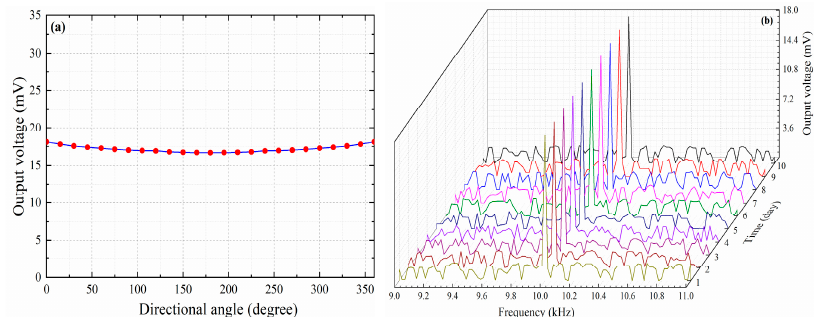
Figure 12. ( a ) Directional response of this proposed sensor. ( b ) Work stability of this proposed sensor during a ten-day test period.